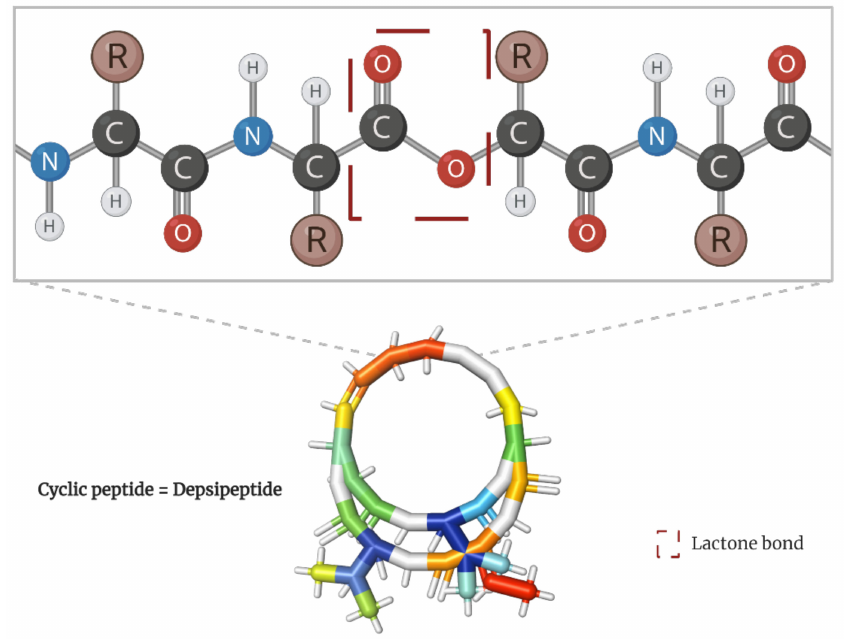
Figure 1. Peptide bond structure of depsipeptides. Lactone bond in the core ring marked in